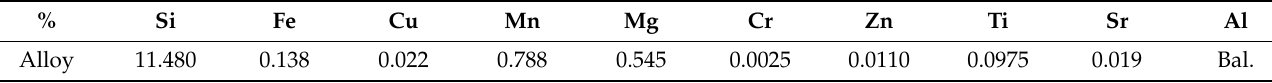
Table 2. Parameters of the heat treatment